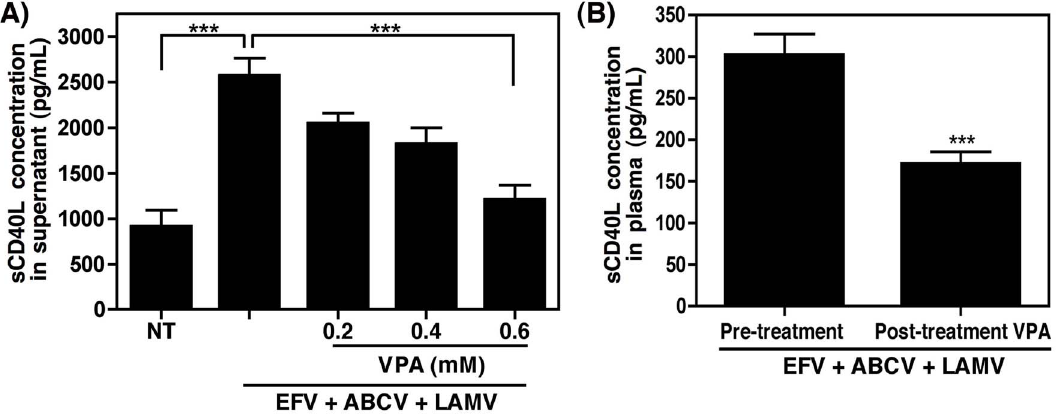
Figure 4. VPA inhibits EFV-induced sCD40L release from platelets both invitro and in HIV infected individuals. (A) Platelets isolated from healthy donors were treated with 5 m M EFV in the presence of NRTIs abacavir and lamivudine (ABCV and LAMV, respectively), and increasing amounts of VPA. The highest dose of VPA, which is equivalent to that measured in patients receiving the standard dose, significantly inhibited the EFV-induced release of sCD40L. Values were compared via one-way ANOVA followed by Bonferroni’s test for multiple comparisons, which indicated statistical significance as ***p , 0.001. (B) Plasma sCD40L levels were analyzed in HIV infected individuals receiving combination antiretroviral therapy including EFV (n=11) prior to initiation of VPA therapy and after 7 days of VPA treatment (250 mg twice a day orally). VPA treatment significantly reduced the amount of sCD40L found in the plasma of these patients. Values were compared using a paired t-test with statistical significance indicated as ***p ,